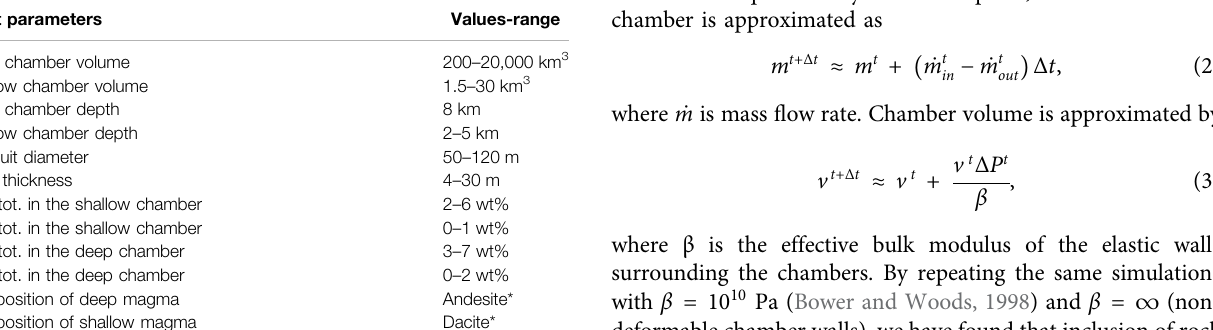
TABLE 1| Input parameters used inthe simulations. Magma temperature istaken to be constant along the entire simulated domain, and equal to 950 ° C *Composition reported in Table